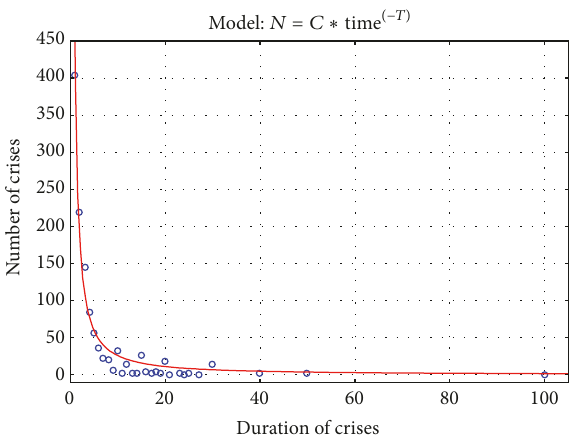
Figure 1: Blue circles represent the real data distribution of duration of crises versus number of crises in one year (scatter-plot graph), whose shape suggests a “power law” distribution. The analytical estimation of the power law distribution has been overimpressed (in